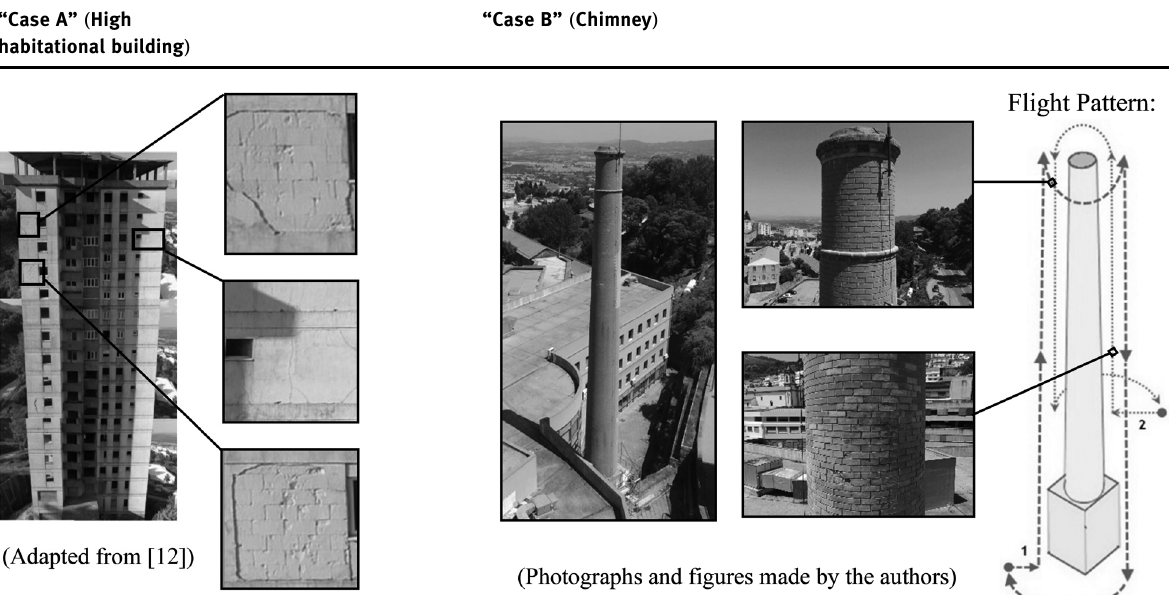
Table 4: Some photographic results of inspections “ Case A ” (